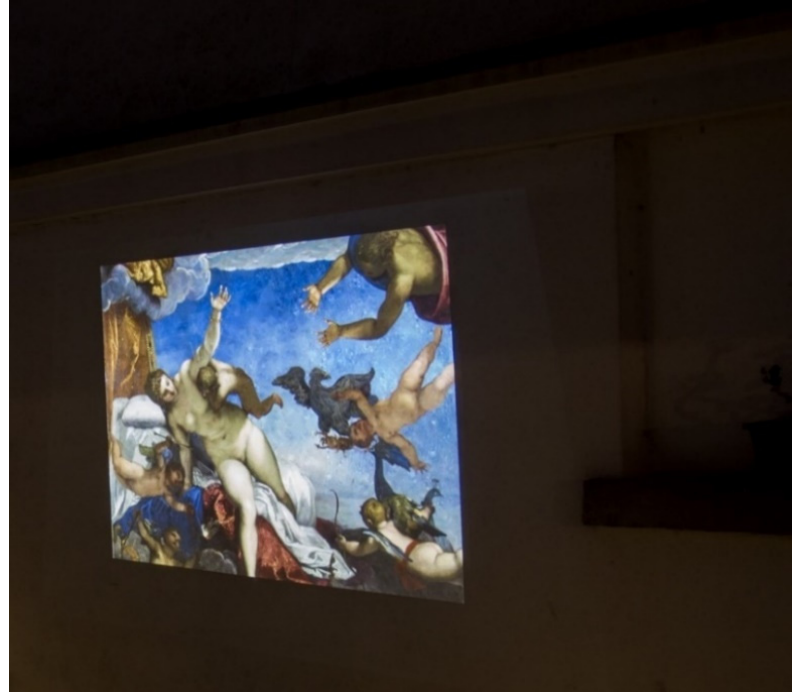
Figure 3. Place of Milky Way . Video projection of the animated painting, by Irmã Lúcia special effects, while next to it (outside) performer Patrícia Portela narrates intertwined stories. Mãe d’Água das Amoreiras Reservoir, Lisbon, 2019. © Joana Linda.